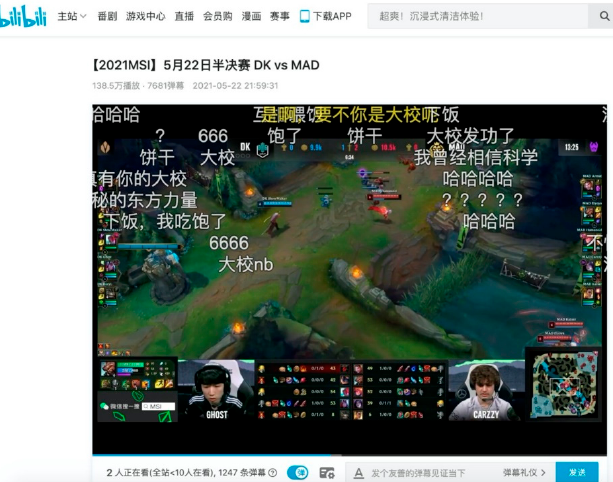
Figure 1. An example of Danmu (Danmu are real-time viewer comments displayed on the screen) on Bilibili.com (accessed on 22 May 2021).